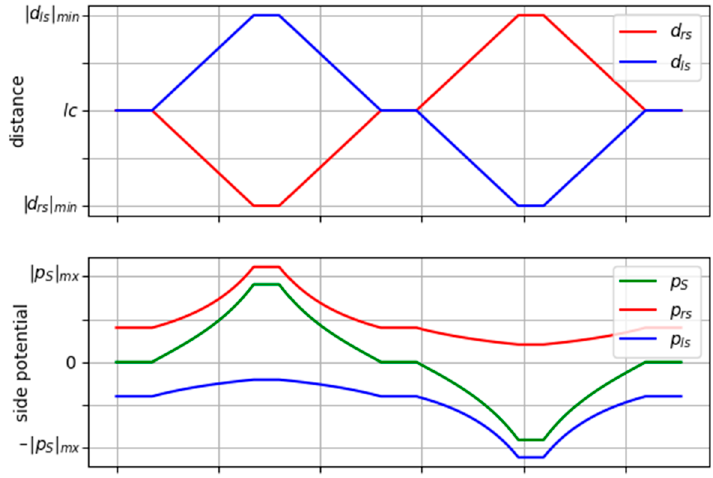
Figure 4. Example of the variation of the side potential field.